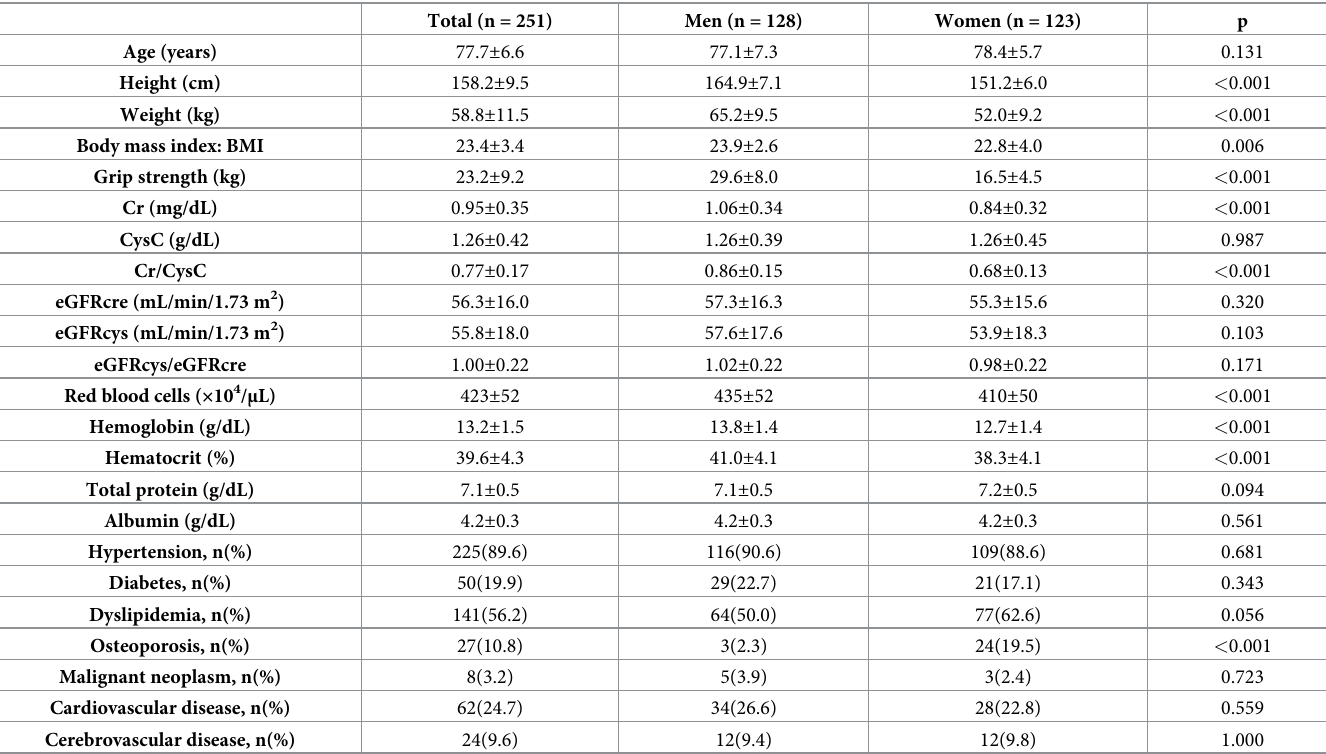
Table 1. Baseline characteristics, physical examination indices, blood examination results, and comorbidity frequency of the participants.